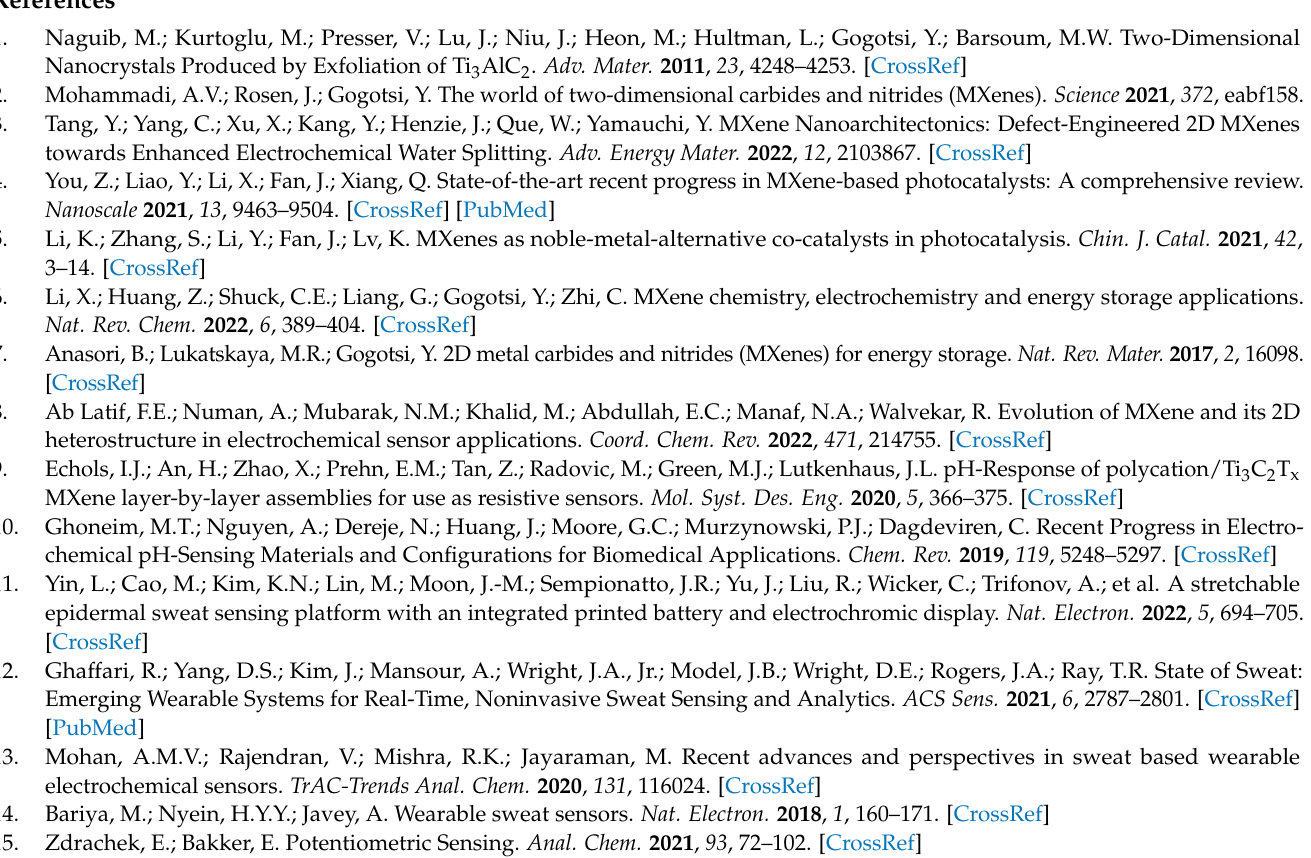
pH sensor under normal and bending state. Figure S6: Potential response of HF-Ti 3 C 2 T x -based pH sensor before and after sweat